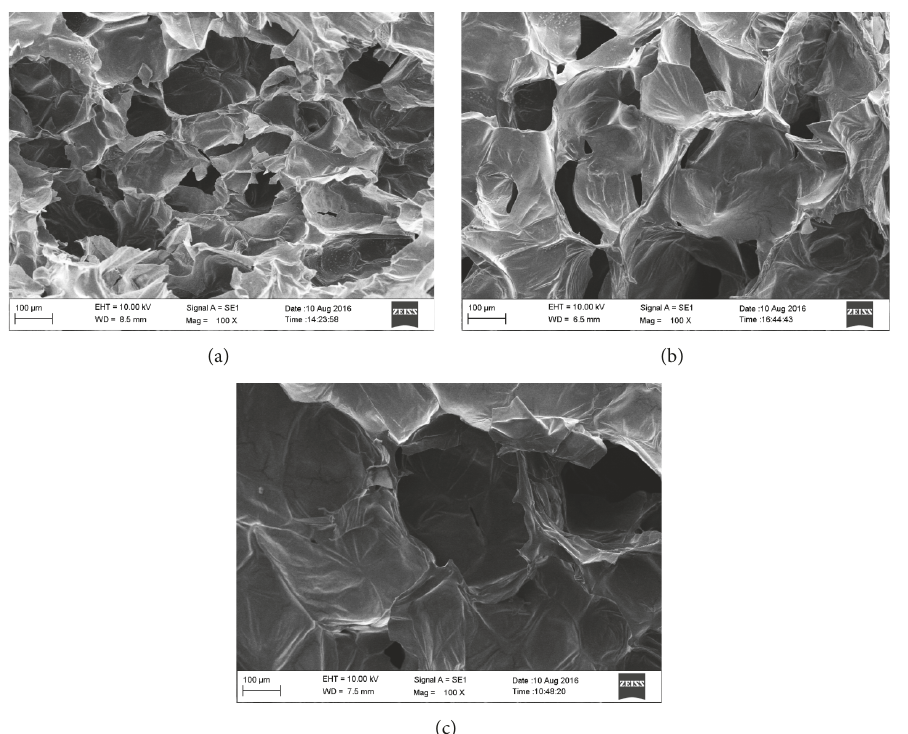
Figure 9: Microphotographs (at 100 magnification) from SEM of freeze-dried samples with 3 freeze-drying methods. (a) VF-FD; (b) HWB- VF-FD; (c) HWB-PF-FD. VF-FD: apple samples without hot-water pretreatment were performed with vacuum freezing treatment and freeze- drying process; HWB-VF-FD: apple samples with hot-water pretreatment were performed with vacuum freezing treatment and freeze-drying process; HWB-PF-FD: apple samples with hot-water pretreatment were performed with plate freezing treatment and freeze-drying